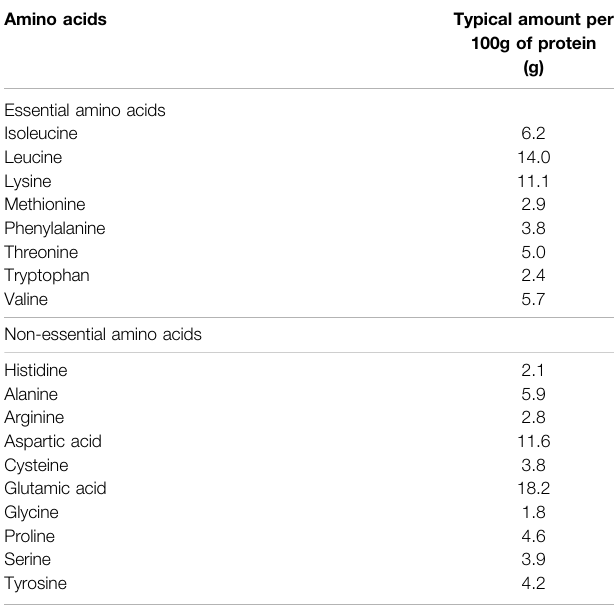
TABLE 1 | Composition of major amino acids in hydrolyzed whey protein Alacen